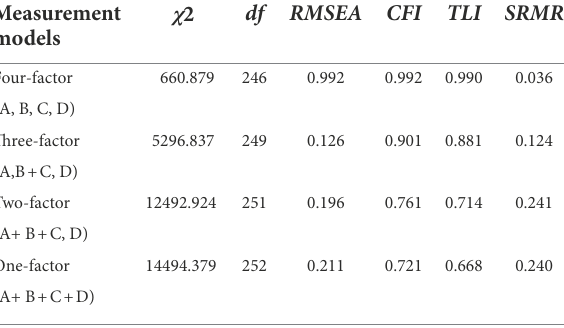
TABLE 2 Results of confirmatory factor analysis of the measurement